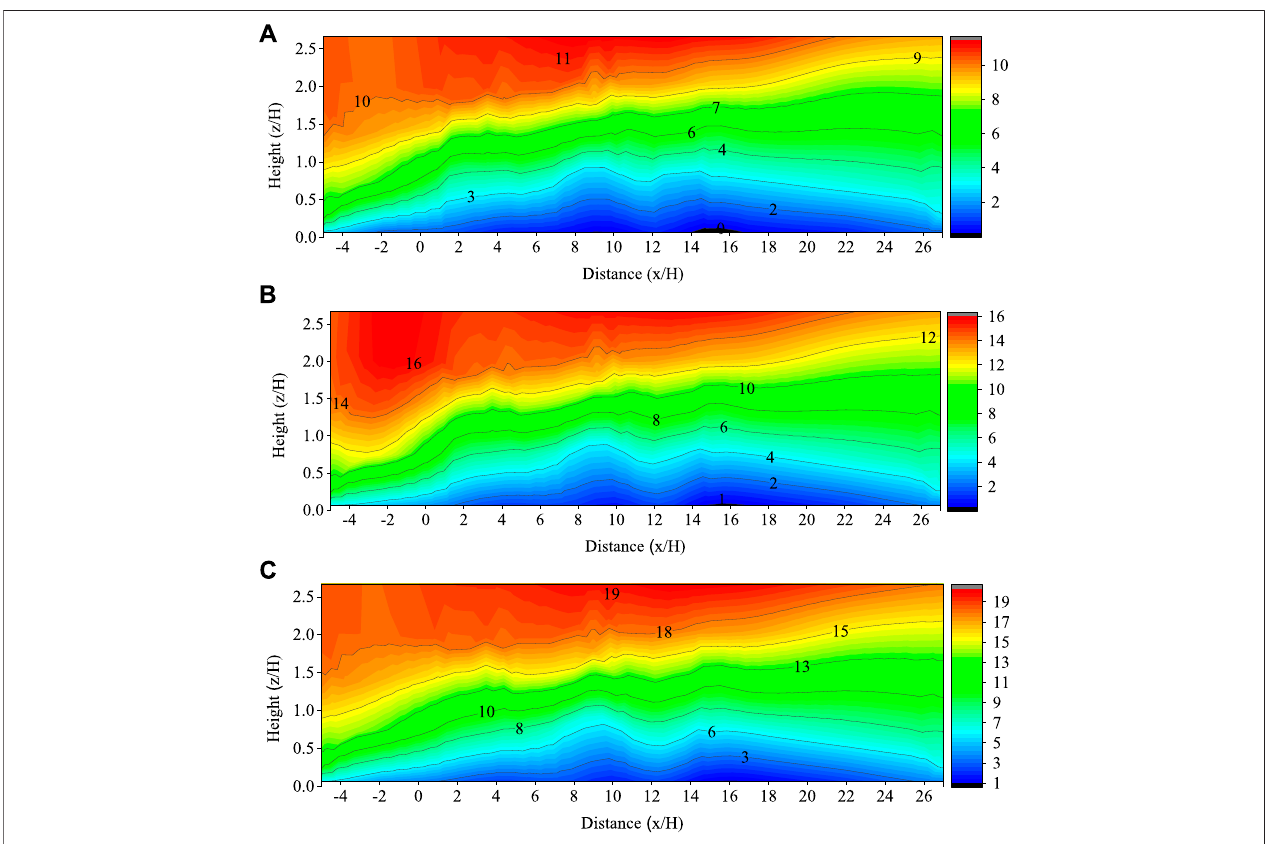
FIGURE10| Thecharacteristicsoftheair fl ow fi eldaroundthethreerowsofwindbreakforestbeltsunderdifferentincomingwindvelocities.Theunitsinparenthesis for all fi gures are m · s − 1 . (A) :V = 8 m · s − 1 , (B) : V = 12 m · s − 1 , (C) : V = 16 m · s − 1 .